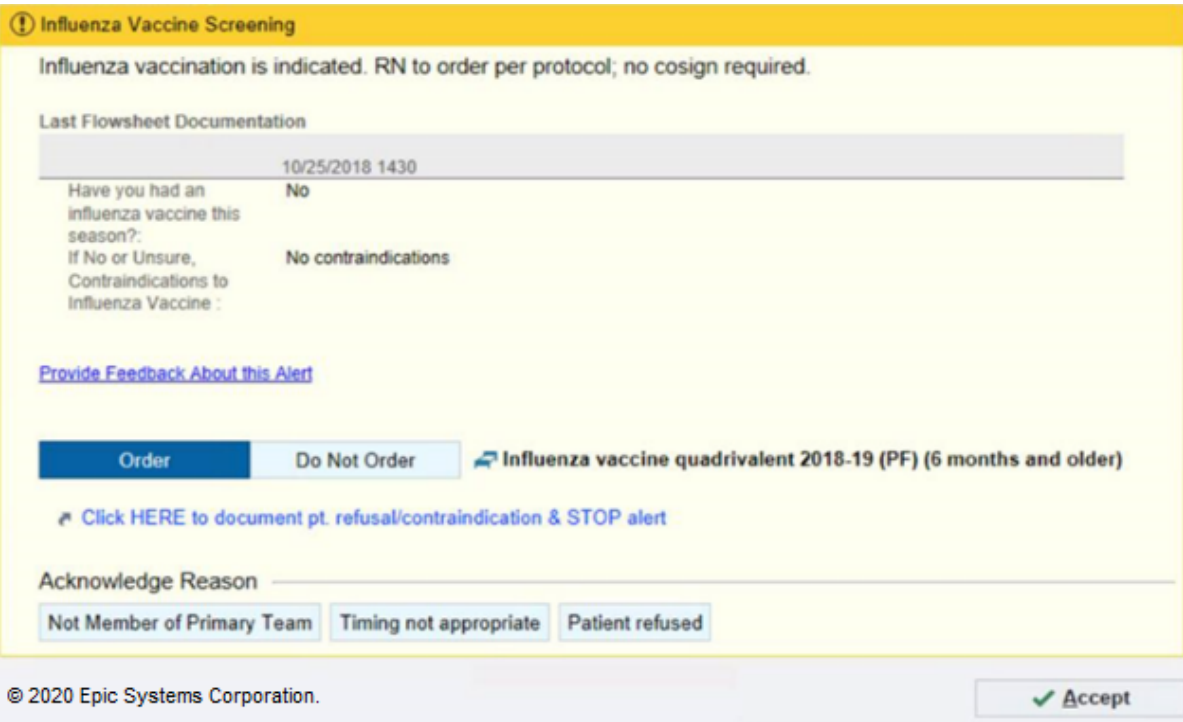
Figure 5. Version 4 of the flu alert, in which new acknowledgement reason buttons with lockout periods and a jumplink to update flowsheet documentation was added, and inappropriate units were excluded. Copyright 2020, Epic Systems